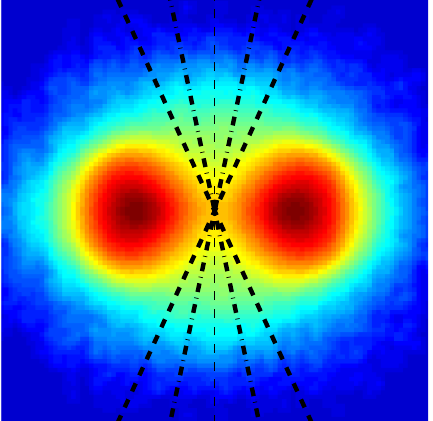
Fig. 10 The presence of the shell of scattered DM material can be quantitatively detected by plotting the projected mass density in a nar- row equatorial sector as the function of the distance from the collision’s center. Shown in this illustration is such quantification, using two sec- torscovering [− 15 ◦ , 15 ◦ ] ( bolddash-dottedline )and [− 30 ◦ , 30 ◦ ] ( bold dotted line ) angles around the equatorial plane ( thin dashed line